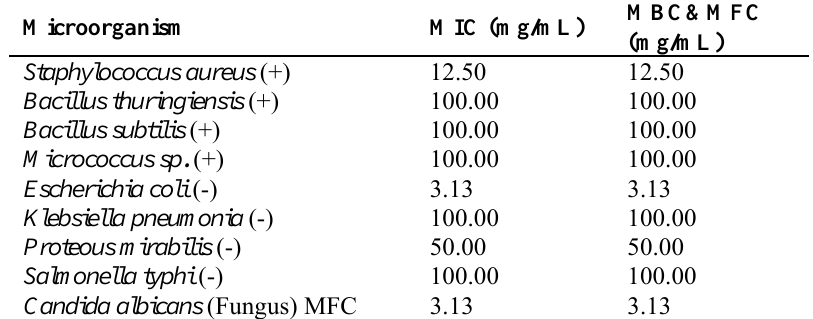
Table 2. Minimal Inhibitory and Bactericidal Concentration of Euphorbia hirta leave extract.